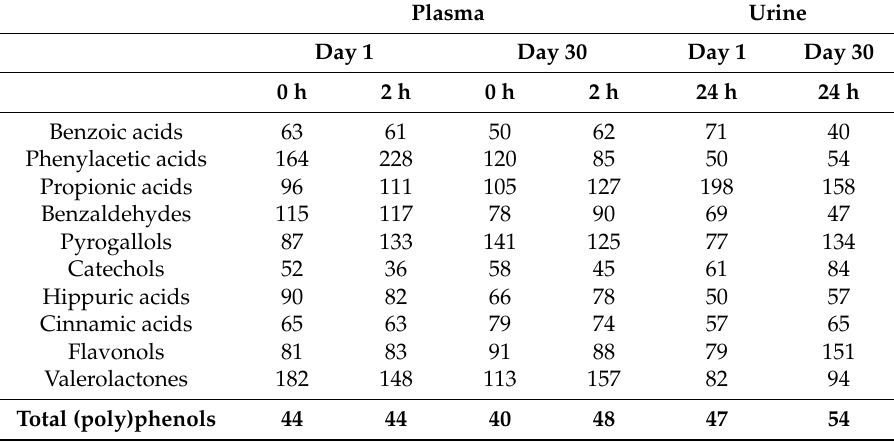
Table 4. Coefficient of variation (%) of (poly)phenols detected in plasma and urine after acute and chronic wild blueberry